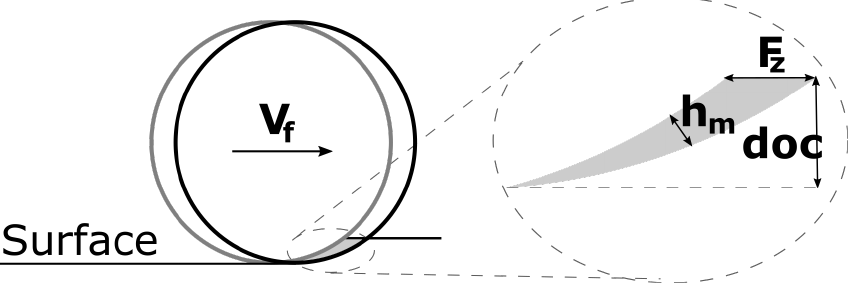
Figure 3. The geometrical definition of the median chip thickness